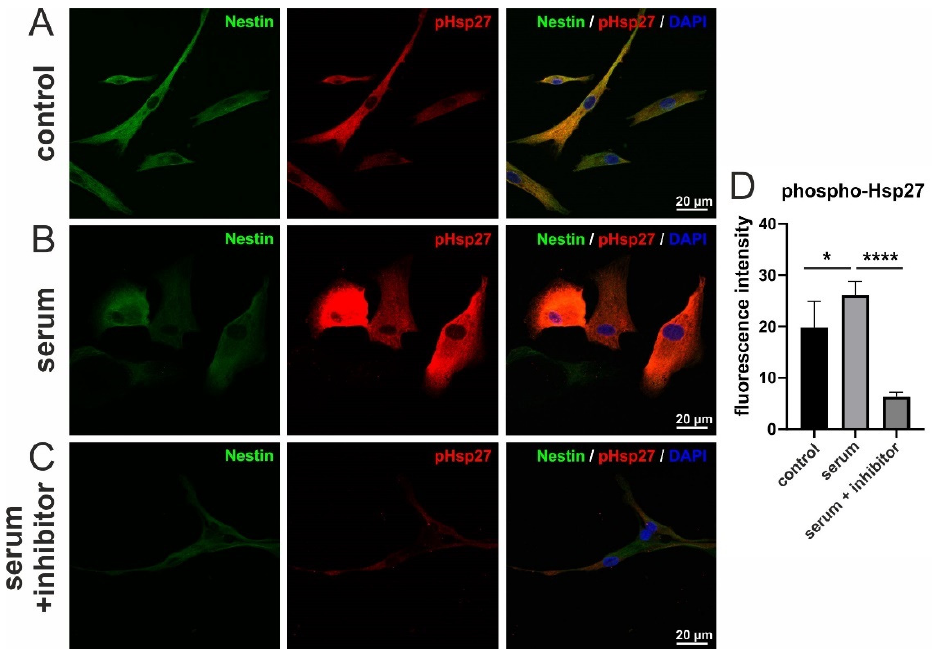
Figure 5. Immunocytochemistry of Nestin and phospho-Hsp27 in hCSCs treated with human serum and p38-MAPK-inhibitor. ( A ) Untreated cells exhibit a basal level of Hsp27 phosphorylation. ( B ) Phosphorylation of Hsp27 in serum-treated cells is strongly increased. ( C ) Hsp27-phosphorylation is inhibited after the application of the p38-MAPK inhibitor SB239063. ( D ) Quantification of fluorescence intensity across all replicates. Measurements were performed with hCSCs from one donor and blood serum from two donors. Mann-Whitney one-tailed, * p < 0.05; **** p < 0.0001 was considered significant.